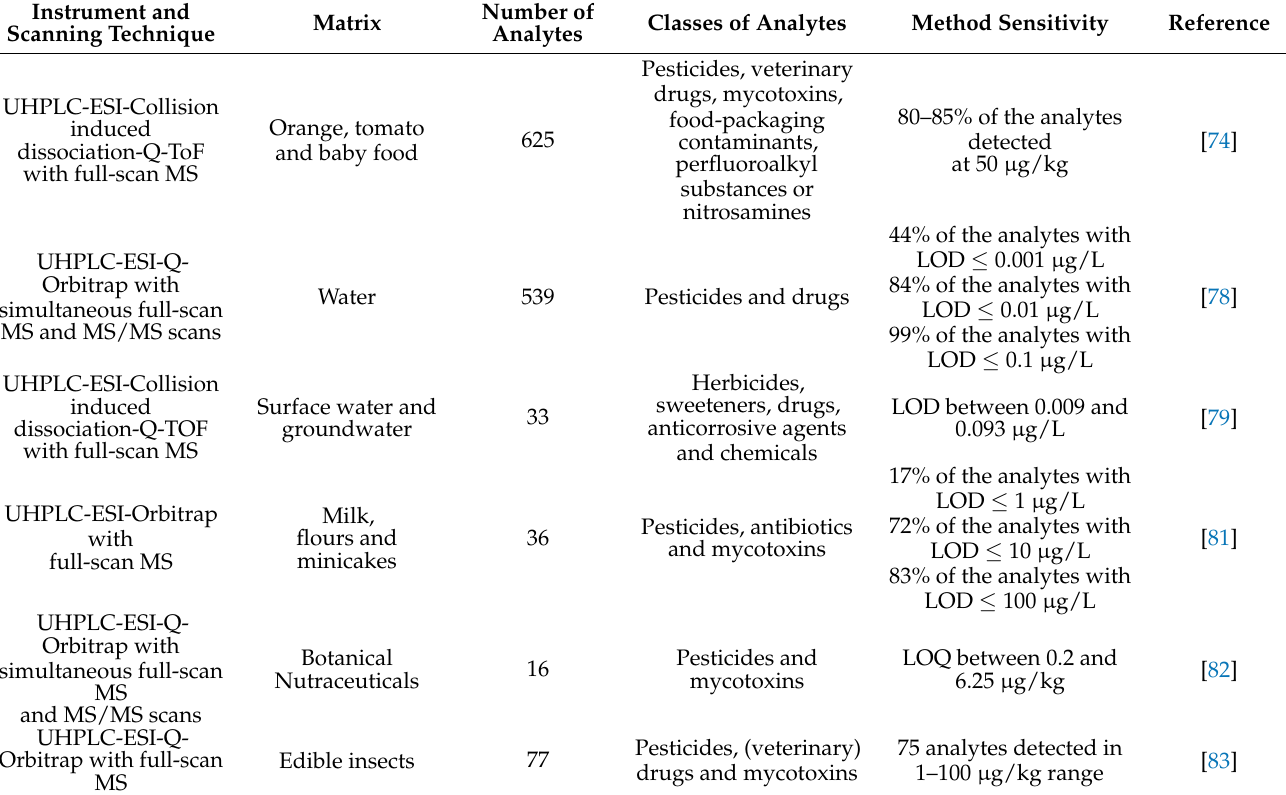
Table 4. Selected studies on HRMS analysis of multi-class